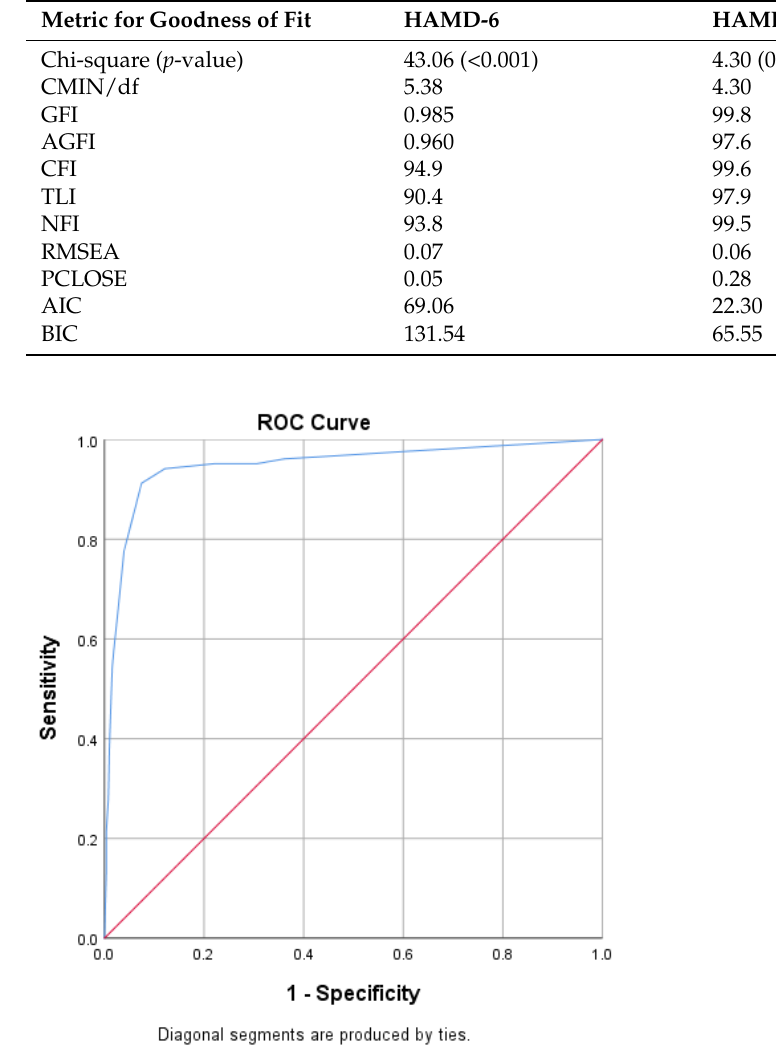
Figure 5. ROC curve for the HAMD-4. Table 2. Fit indices for the HAMD-6 and HAMD-4.